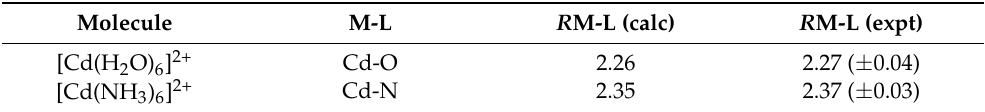
Table 1. Comparison between Computed and Experimental Average Metal-Ligand (M-L) Bond Distances (in